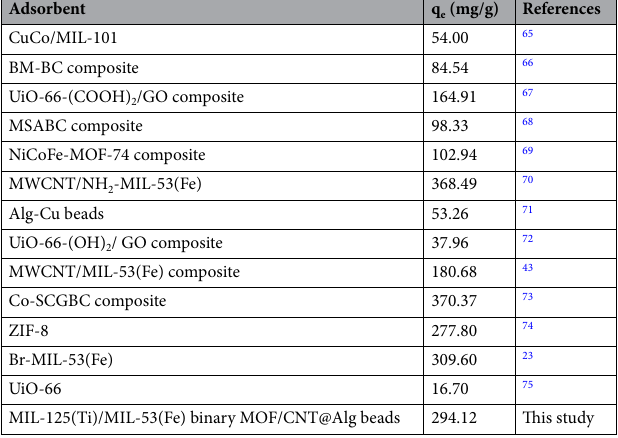
Table 2. Comparison between the adsorption capacity of MIL-125/MIL-53binary MOF/CNT@Alg composite microbeads and other adsorbent towards the adsorption of